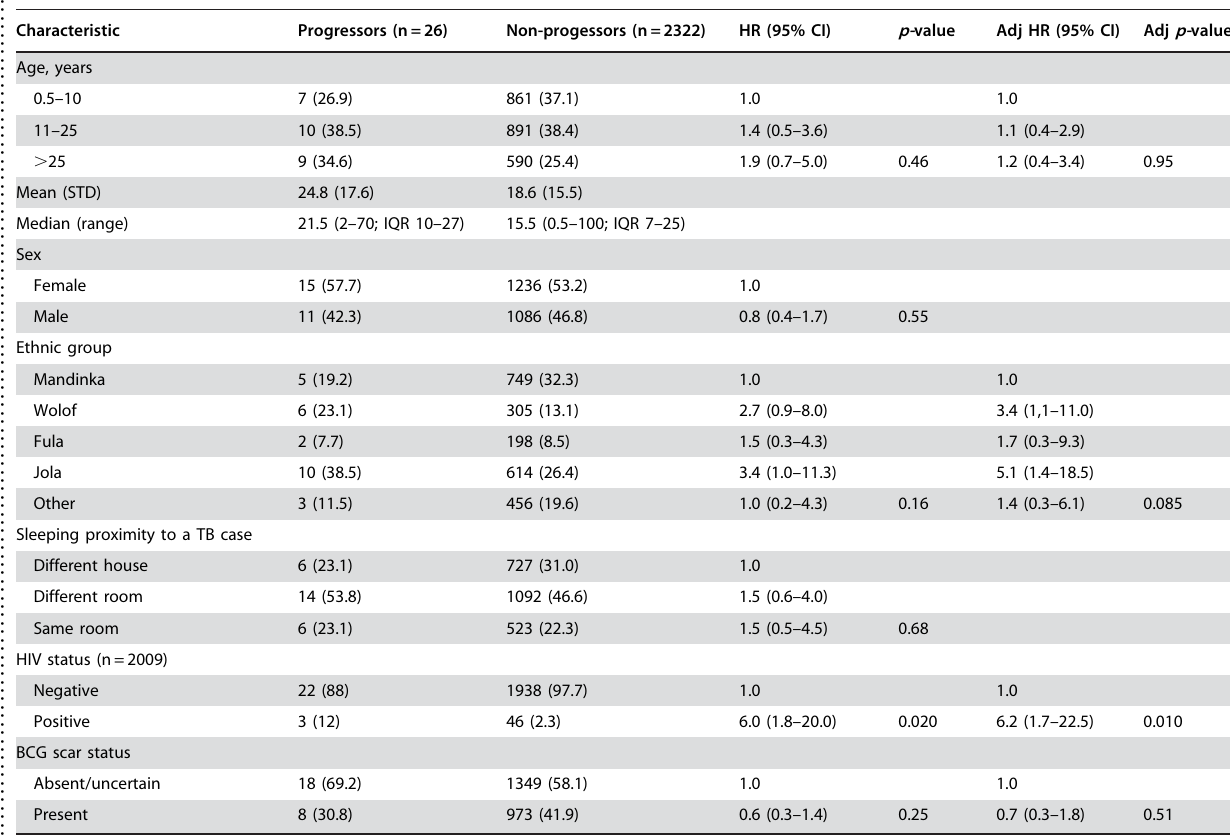
Table 1. Baseline information of TB case contacts who progressed to disease (n =26) and those who did not (n=2322). .. ... .... ... ... .... ... ... .... ... ... .... ... ... .... ... ... .... ... ... .... ... ... .... ... ... .... ... ... .... ... ... .... ... ... .... ... ... .... ... ... .... ... ... .